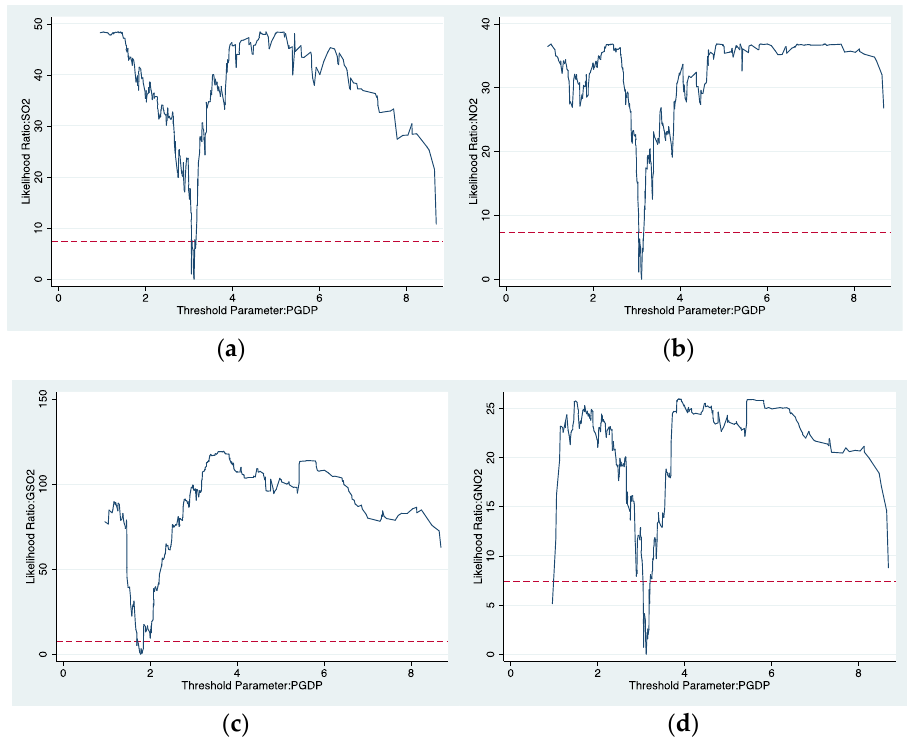
Figure 2. LR function graph of threshold variables: ( a ) SO 2 ; ( b ) NO 2 ; ( c ) GSO 2 ; ( d ) GNO 2 .